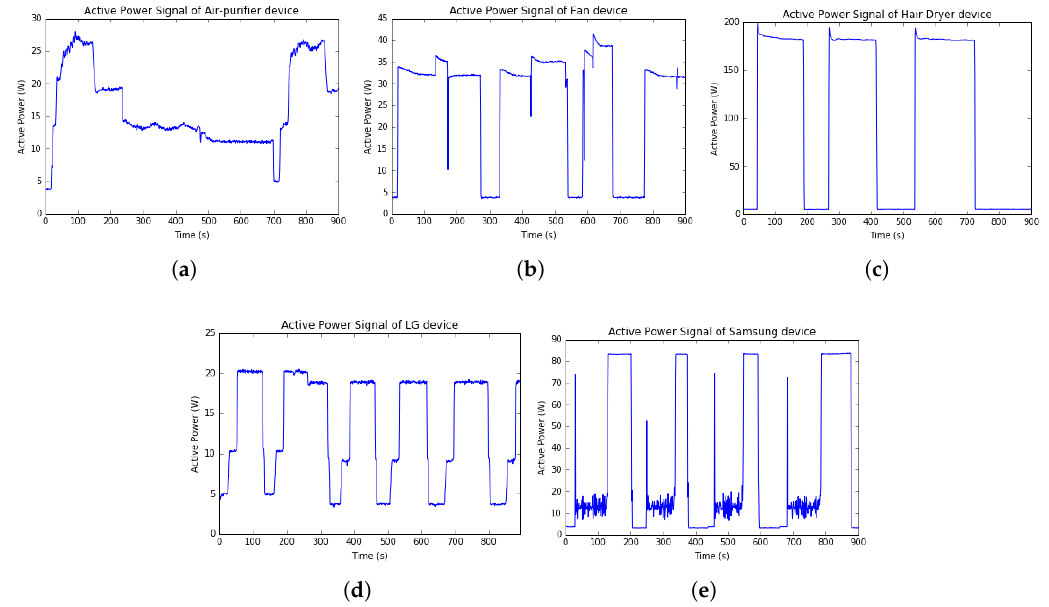
Figure 10. Active power signals: ( a ) Airpurifier; ( b ) Fan appliance; ( c ) Hairdryer appliance; ( d ) LG monitor appliance; ( e ) Samsung monitor